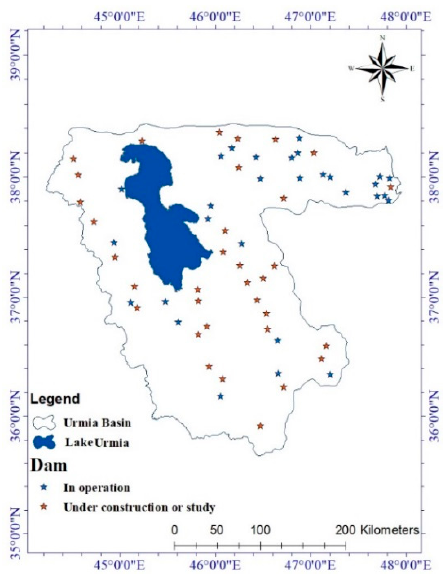
Figure 9. Dam locations of the Urmia Basin.